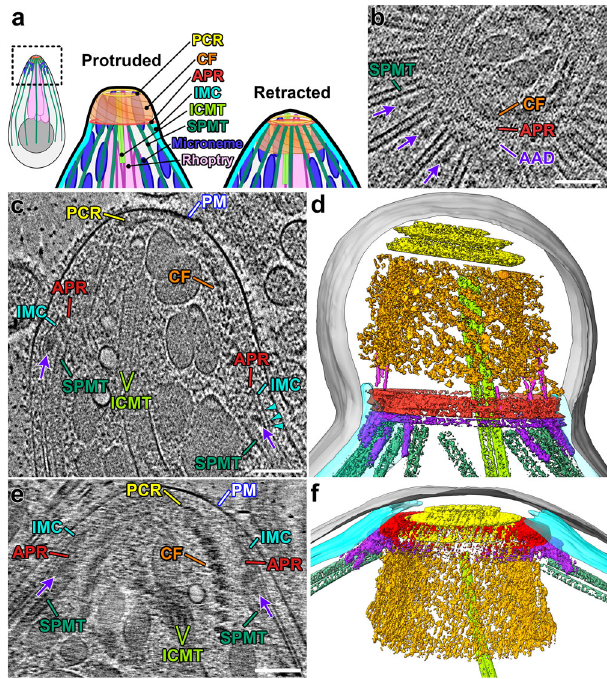
Fig. 1 | Three-dimensional in situ architecture of the apicomplexan invasion machinery revealed by cryo-FIB milling and cryo-ET. a Cartoon overview of the components of the coccidian apical complex comparing the protruded and retracted states. This coloring scheme will be used throughout the manuscript. b Tomographicslicethroughapartiallyretractedconoidthatwascryo-FIBmilledin cross-sectional orientation, clearly shows the SPMTs ending neartheAAD ring and with AAD projections (purple arrows) interspersed between neighboring SPMTs. c Tomographicslice of the reconstructedapicalend of N.caninum with protruded conoid. Note the density connecting the two membranes of the inner membrane complex (IMC, cyan arrowheads). For other labels and coloring, see below. d 3D segmentation and visualization of the apical complex from a protruded conoid (different tomogram from ( c )). Labels and colors used throughout the manuscript unlessotherwisenoted:AAD(purple),amorphousAPR-associateddensityringand projections; actin-like fi laments (magenta in ( c )); APR (red), apical polar rings; CF (orange) conoid fi ber, ICMT (light green) intraconoidal microtubules, IMC (cyan) inner membrane complex, PCR (yellow) pre-conoidal rings, PM (gray) plasma membrane, SPMT (dark green) subpellicular microtubules. e Tomographic slice of the reconstructed apical end of a milled N. caninum with a retracted conoid, annotated as in ( c ). f 3D segmentation and visualization of a retracted conoid (differenttomogramfrom( e ))andcoloredasin( d ).Inlongitudinalviews,anapical tip is oriented towards the top of the images throughout the manuscript, unless otherwise noted. Scale bars: 100nm (in b – e